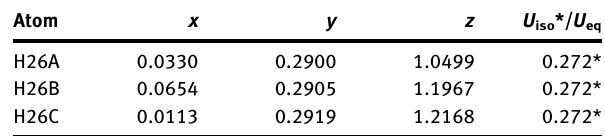
Table  : Fractional atomic coordinates and isotropic or equivalent isotropic displacement parameters (Å 